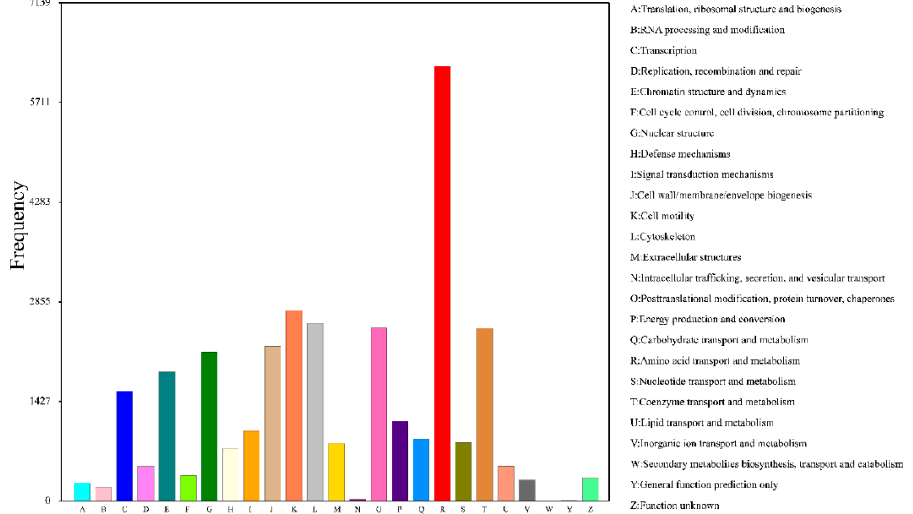
Figure 9. COG annotation classification statistics of expressed genes.